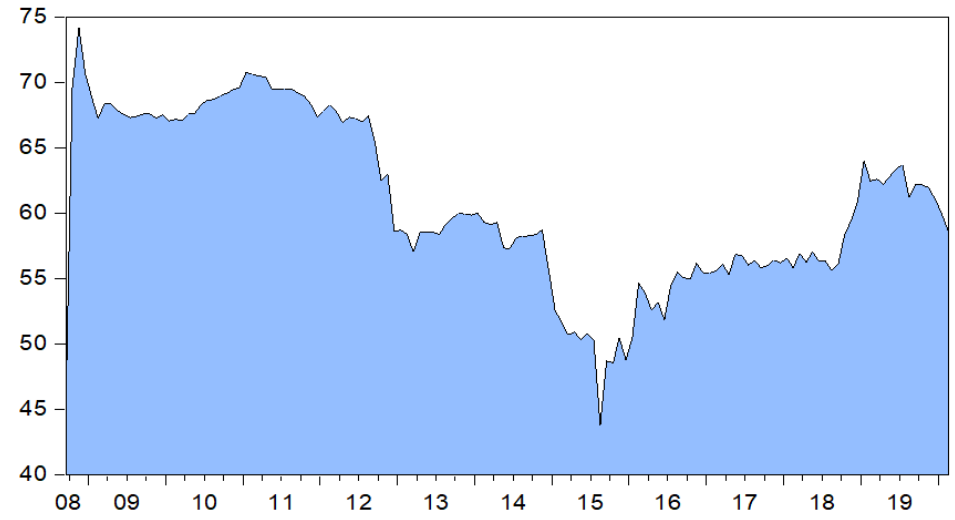
Figure 2. Rolling total volatility spillover index estimates among the clean energy (CE), S&P 500 (ST), technology (TE), and crude oil (WTI) series. Note: the x -axis indicates the time and the y -axis shows the percentage change in the total spillover